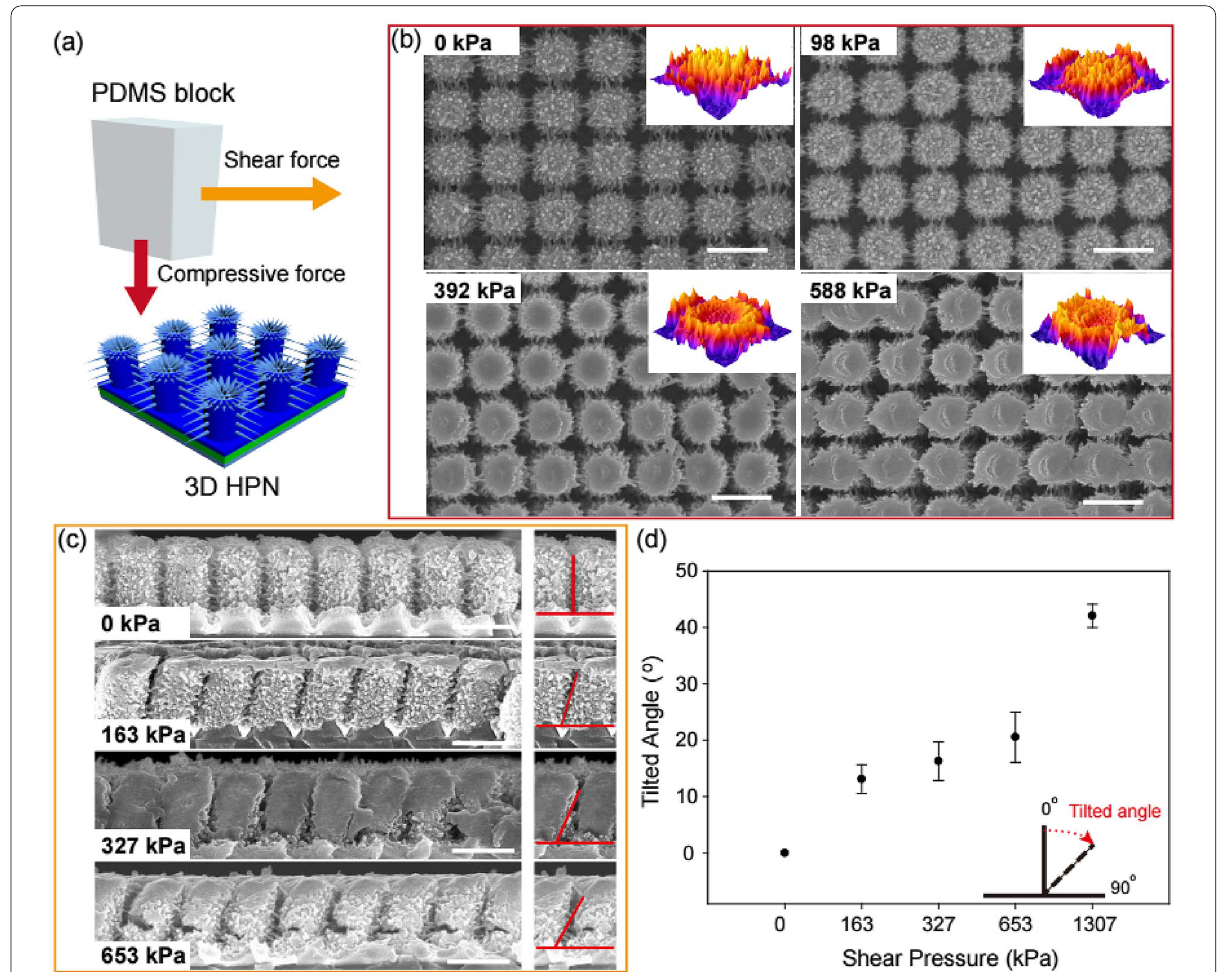
Fig. 2 Investigation of the mechanical resistance of the 3D HPN against compressive and shear forces. a Schematic of the mechanical test of 3D HPN using the PDMS block. b Surface SEM images of the 3D HPN after a 0 ‒ 588 kPa compression pressure was applied. Insets are 3D transformed images of corresponding samples, particularly for a single nanopillar. c Cross‑sectional SEM images of the 3D HPN after a 0 ‒ 653 kPa shear pressure was applied. d Declined angles of the 3D HPN according to shear pressure. Scale bar is 1